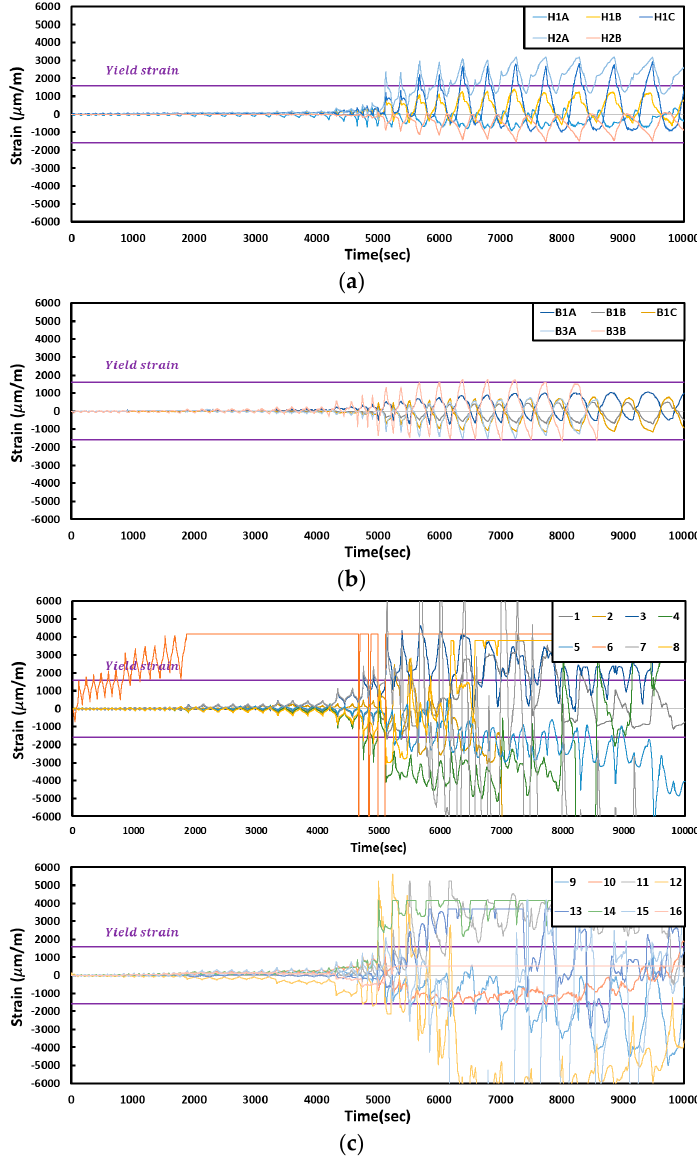
When displacement was 30.375 mm, the strains that were observed at Gauges 9, 13, 11, 4, 8 and 12